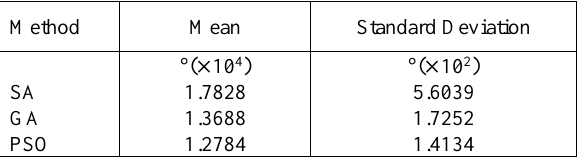
Table 7. Mean and Standard deviation of the objective functions